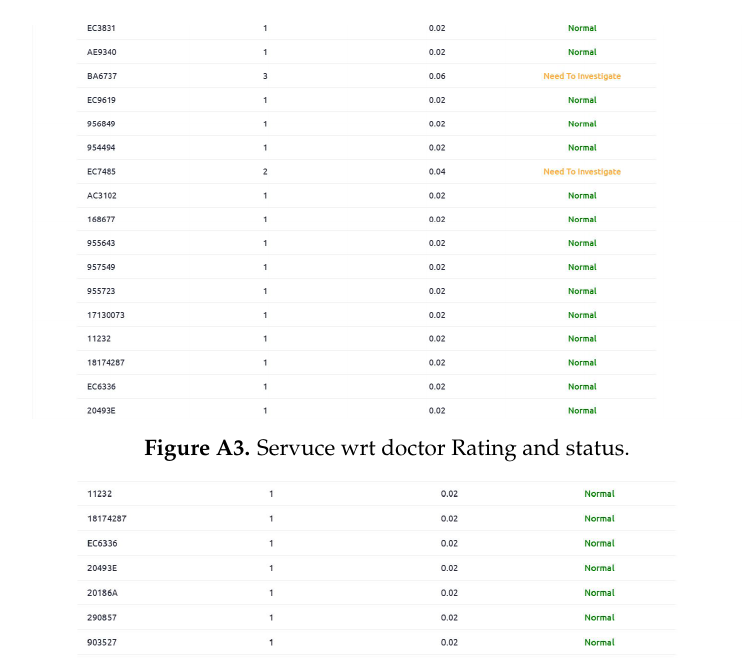
Figure A4. Servuce wrt doctor Rating and status.